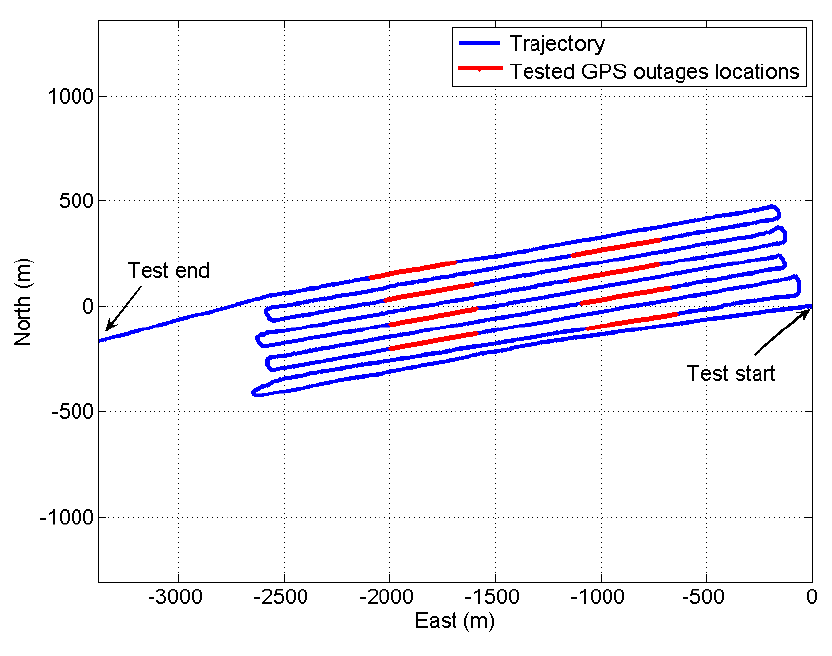
Figure 6. GPS test trajectory (blue) used to develop the model and GPS artificial outages (red) to test the